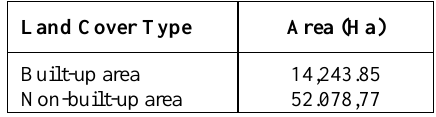
Figure 3. Maps resulting from the change detection process in 2020 : (a) soft prediction and (b) hard prediction Figure 3 shows several differences in the hard and soft prediction models. The hard prediction yielded a map with information on land cover changes in 2020, whose classification was determined according to the inputted data: non-built-up and built-up areas. The non-built-up area is marked green, while the built-up land is